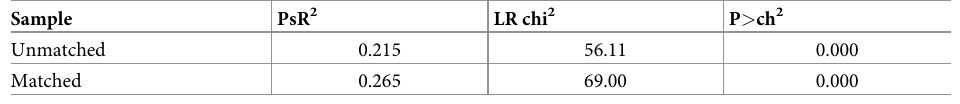
Table 9. Chi-square test for the joint significance of